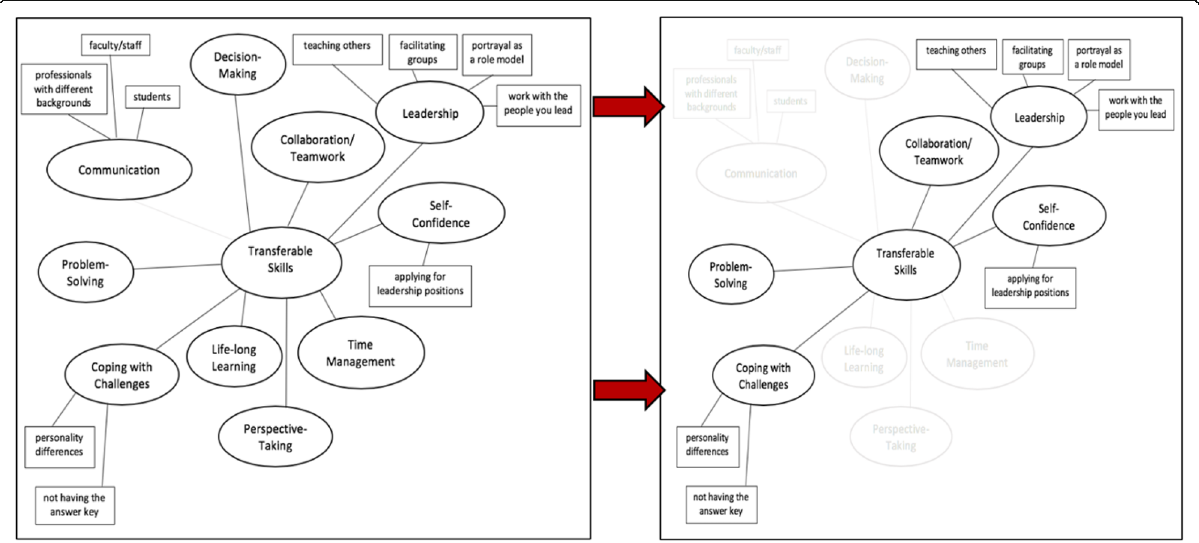
Fig. 2. Thematic mind map after coding iterations. Mind map 1 (left) shows the beginning coding scheme whereas mind map 2 (right) shows the results after coding